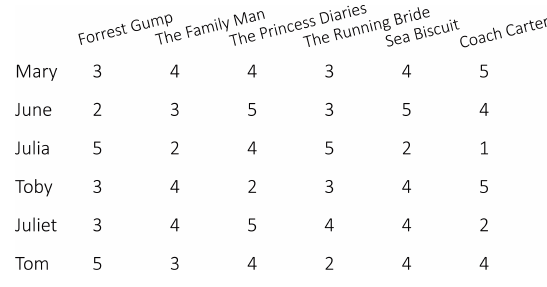
Fig. 3 Score of users to